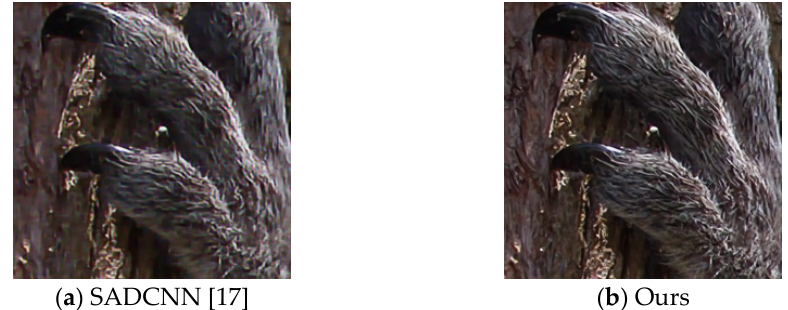
Figure 7. Comparison with detail restoration between SADCNN and Ours.